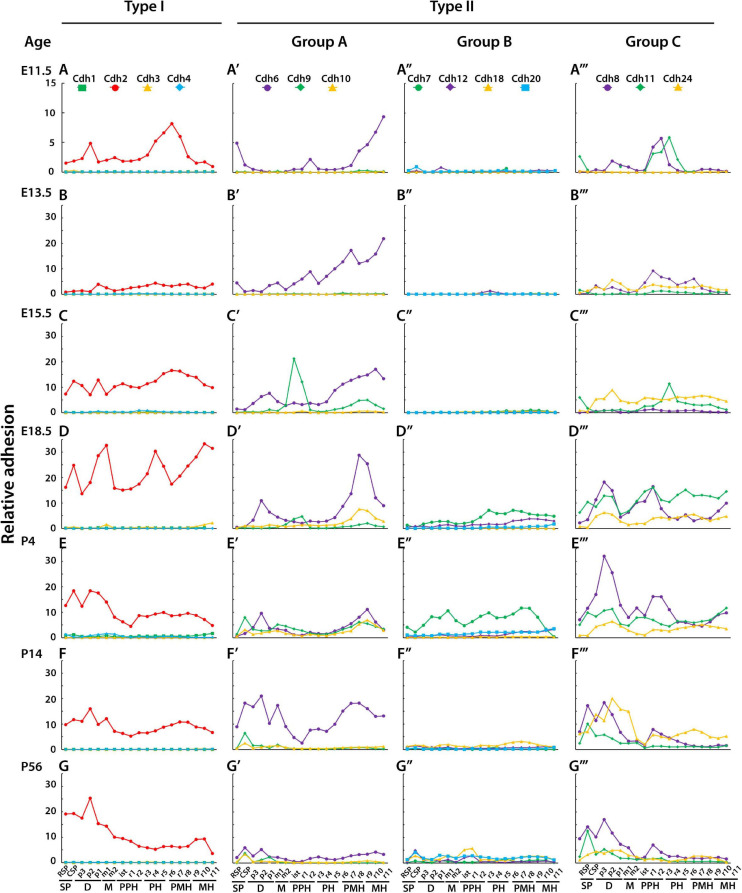
Relative adhesion values of classical cadherins during CNS development. The relative adhesion of cadherins in each neuroanatomical segment (at ontogenetic level 3) along the anterior–posterior axis was estimated based on the level of cadherin mRNA expression (detected by ISH) and homophilic binding affinity (anterior is to the left). One unit of mRNA expression energy was normalized to 25,000 cadherin molecules, and adhesion forces were estimated based on the number of molecules and homophilic binding affinity as previously described (see section “Materials and Methods”). (A–G) type I cadherins; (A′–G′) type II cadherins group A; (A′′–G′′) type II cadherins group B; (A′′′–G′′′) type II cadherins group C. (A–A′′′) E11.5; (B–B′′′) E13.5; (C–C′′′) E15.5; (D–D′′′) E18.5; (E–E′′′) P4; (F–F′′′) P14; and (G–G′′′) P56. SP, secondary prosencephalon; D, diencephalon; M, midbrain; PPH, prepontine hindbrain; PH, pontine hindbrain; PMH, pontomedullary hindbrain; MH, medullary hindbrain; RSP, rostral secondary prosencephalon; CSP, caudal secondary prosencephalon; p, prosomere; m, mesomere; is, isthmus; r, rhombomere.